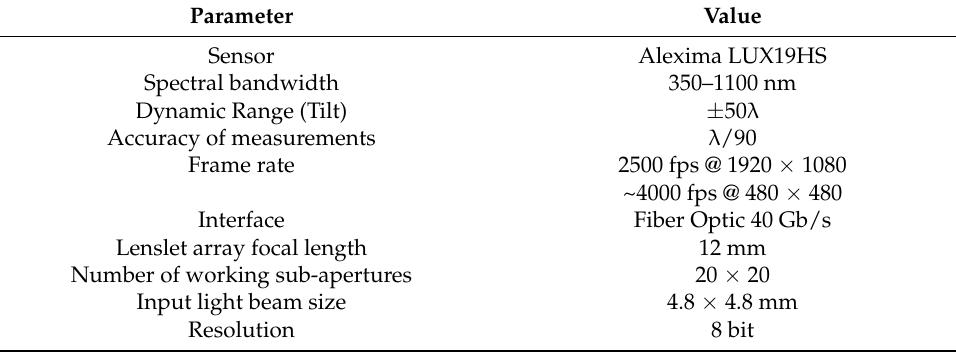
Table 2. Main parameters of the wavefront